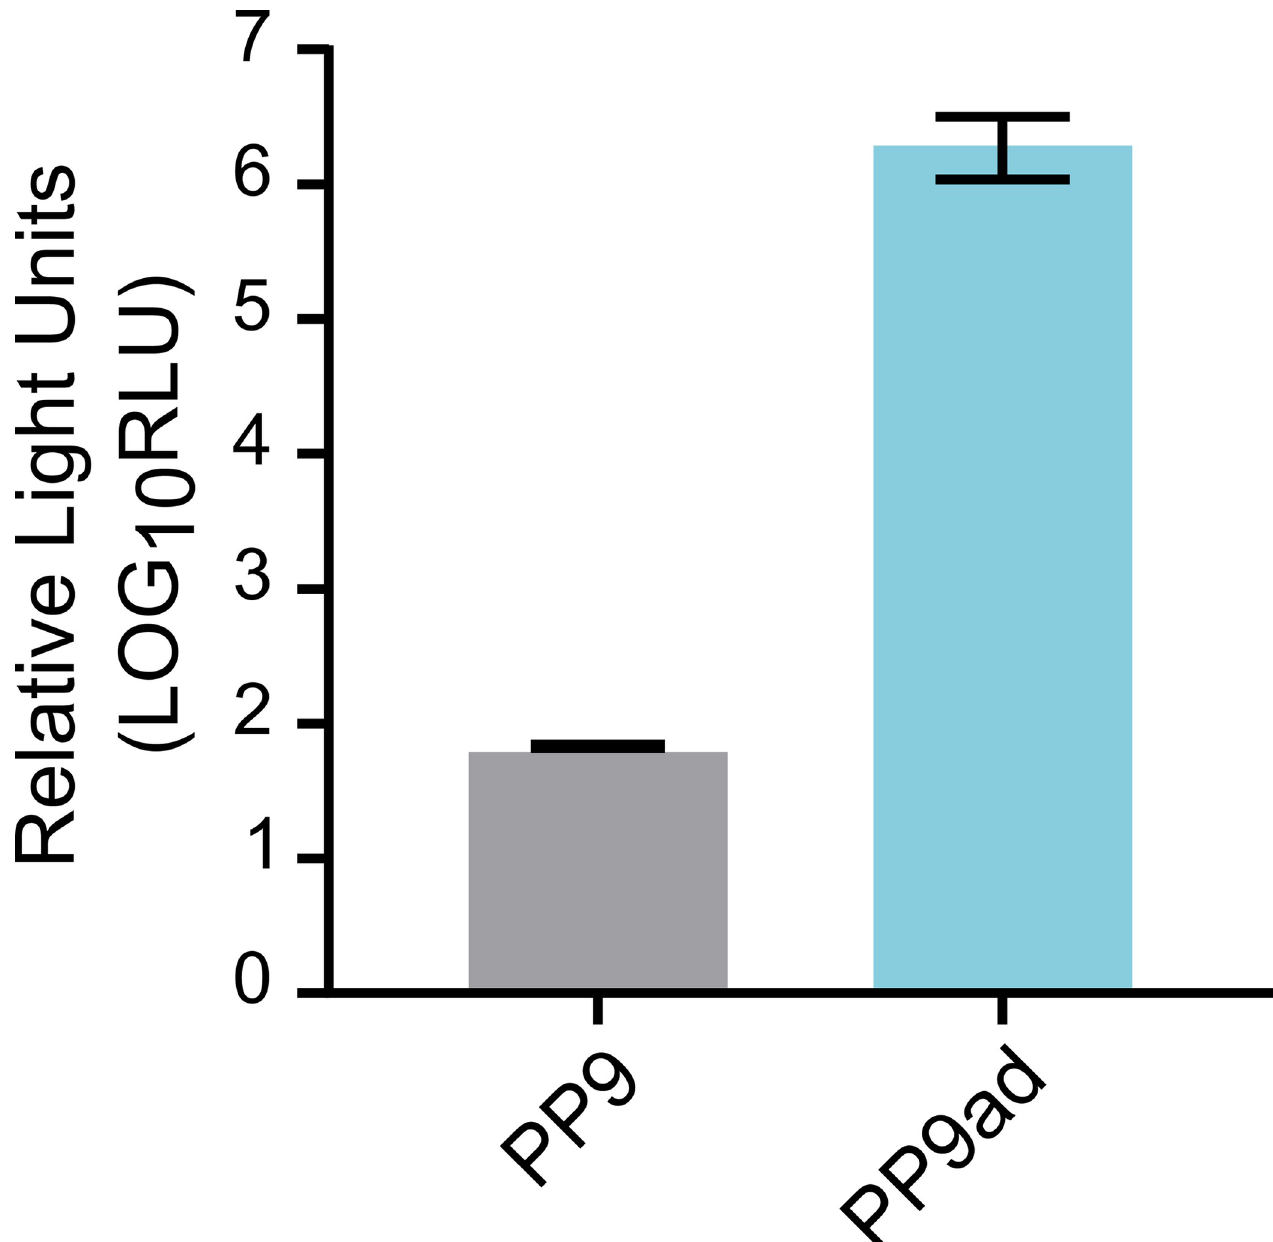
Fig 1. FFLuc activity in transfected PP9 versus PP9ad cell lines. PP9 and PP9ad cells were transfected with pGL3-Pub. At 72 h.p.t., cells were harvested and FFLuc activity was measured and normalized to untransfected. Shown is the relative light output from pGL3-PUb transfected cells, using TransIT-LT1. The figure shows data from three independent experiments, each conducted with three technical replicates. Data presented reflect mean values and error bars depict standard error of the mean (SEM).